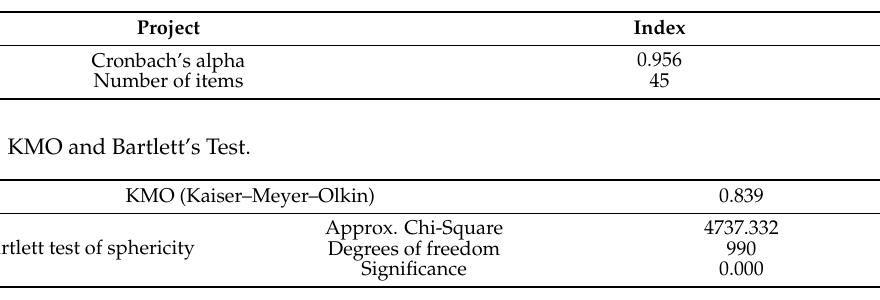
Table 2. Reliability analysis.